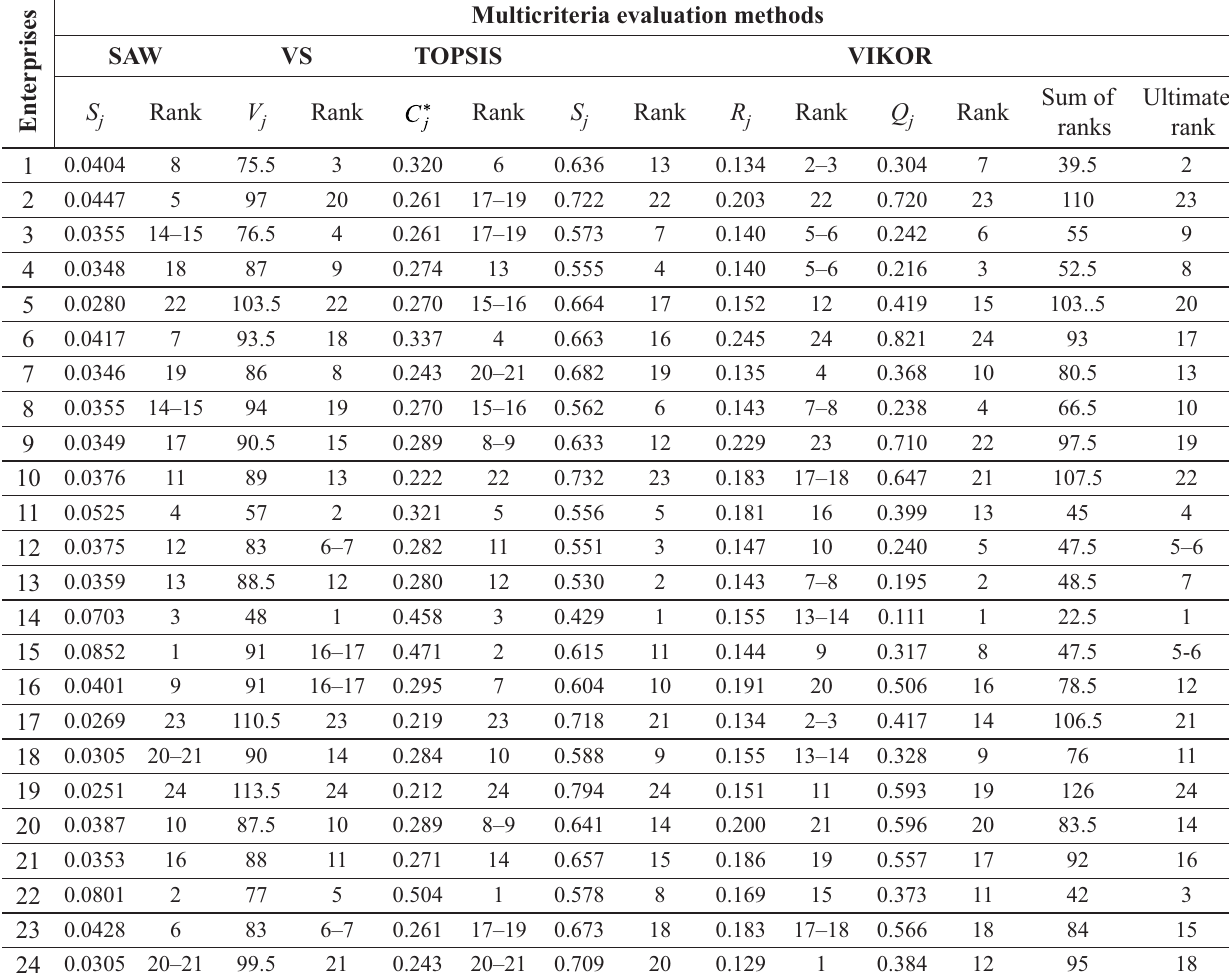
Table 7. General estimates of aid criteria obtained by multicriteria